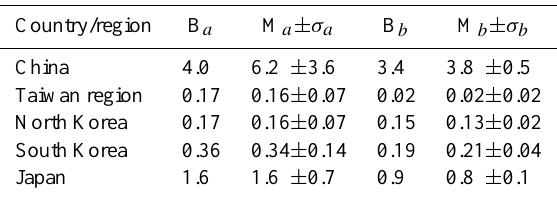
Table 9. HFC-152a emissions (kt/yr) per country/region for the year